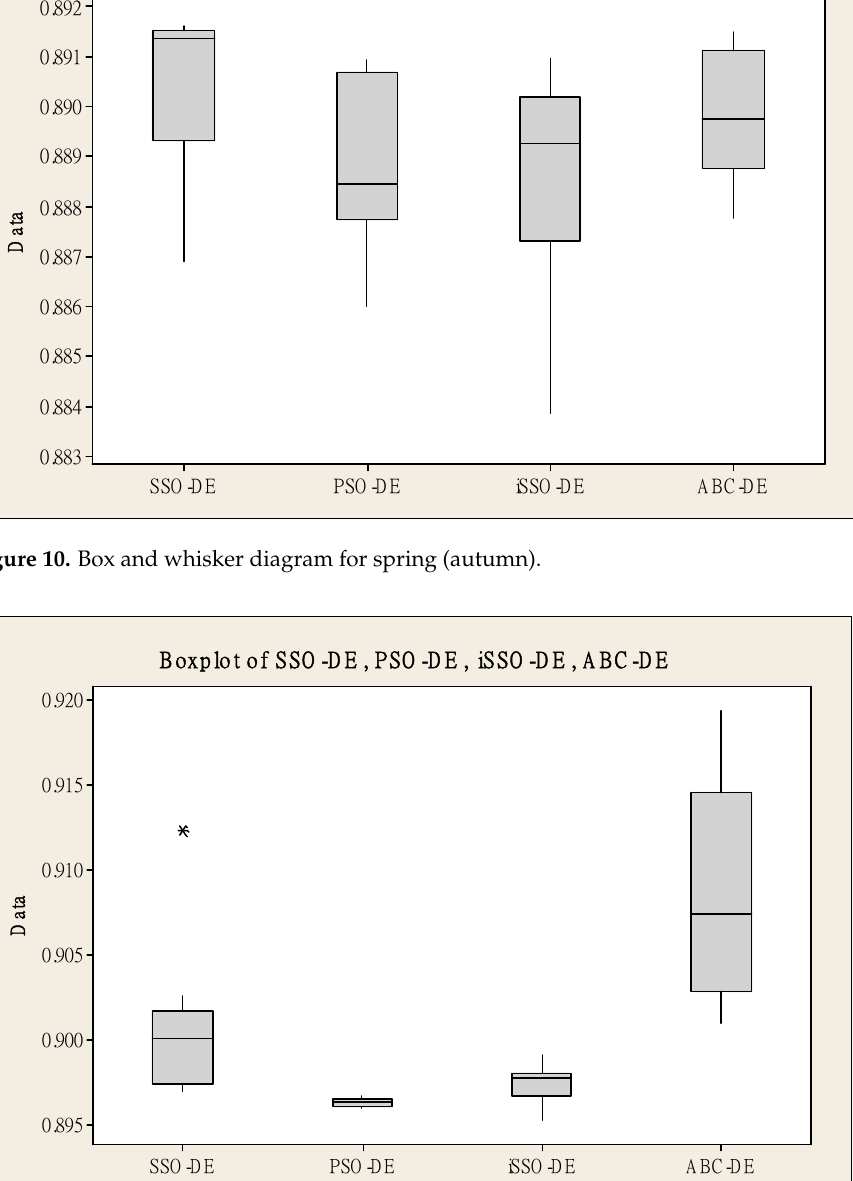
Figure 11. Box and whisker diagram for summer. *: Outliers.